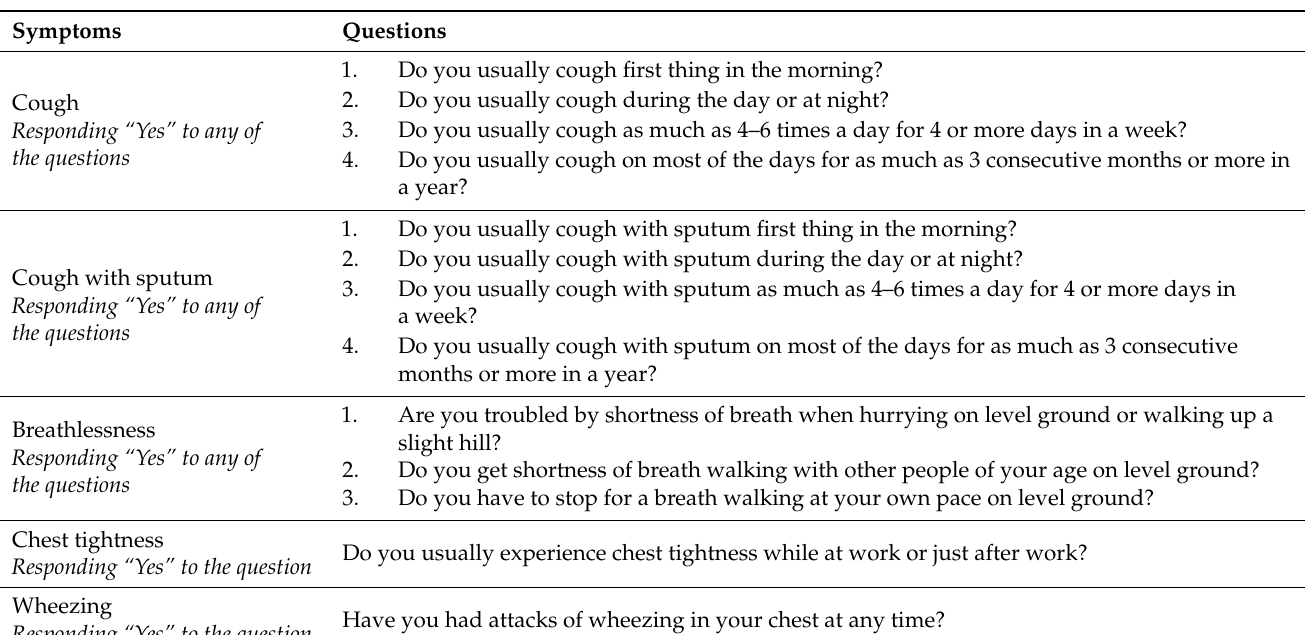
Table 1. Operational definitions of different respiratory